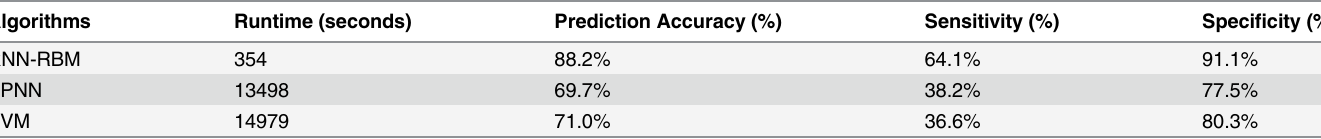
Table 3. Comparison of traf fi c congestion prediction performance for different algorithms with 60-minute data aggregation level. Algorithms